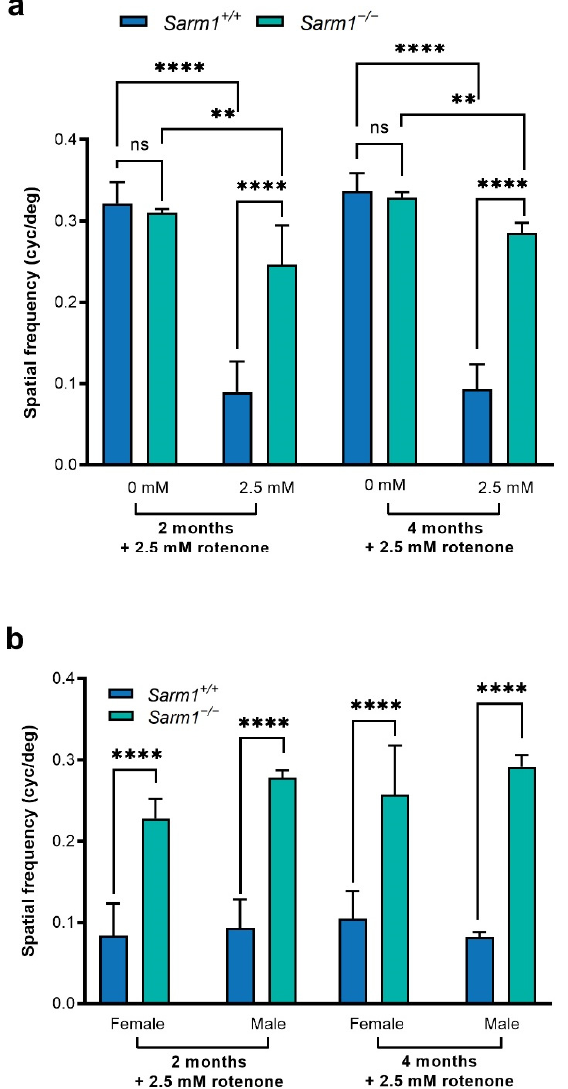
Figure 1. Spatial vision following rotenone insult. Rotenone was delivered bilaterally via intravitreal injection. Optokinetic responses were measured 2 months and 4 months post-injection using an OptoMotry virtual optokinetic system (Cerebral Mechanics). Bar charts represent the mean combined spatial frequency threshold. Error bars represent SD, ** p < 0.01, **** p < 0.0001. ( a ) Sarm1 − / − mice retained a higher spatial frequency threshold following rotenone treatment compared to wild type mice. This was sustained over time (0.25 ± 0.05 cyc/deg vs. 0.09 ± 0.04 cyc/deg at 2 months post- injection; 0.29 ± 0.01 cyc/deg vs. 0.09 ± 0.03 cyc/deg at 4 months post-injection). ( b ) Spatial vision was preserved in both sexes over time (2 and 4 months post-injection), with no significant differences between the sexes within genotypes (2 months post-rotenone: female Sarm1 +/+ 0.08 ± 0.04 cyc/deg vs. female Sarm1 − / − 0.23 ± 0.02 cyc/deg, p < 0.0001; male Sarm1 +/+ 0.11 ± 0.03 cyc/deg vs. male Sarm1 − / − 0.26 ± 0.06, p < 0.0001. 4 months post-rotenone: female Sarm1 +/+ 0.09 ± 0.03 cyc/deg vs. female Sarm1 − / − 0.28 ± 0.01 cyc/deg; p < 0.0001, male Sarm1 +/+ 0.08 ± 0.01 cyc/deg vs. male Sarm1 − / − 0.29 ± 0.01 cyc/deg, p <